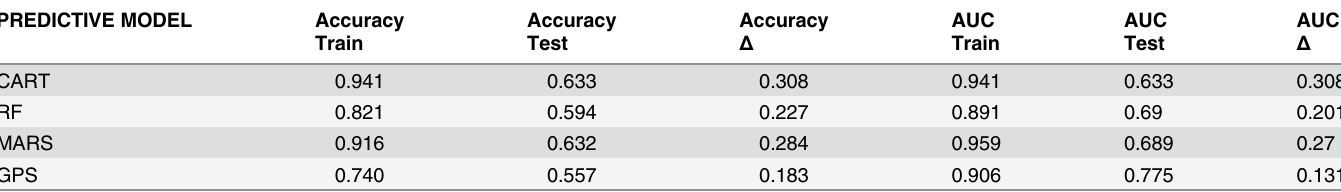
Table 6. Comparison of performance of machine learning classifiers.